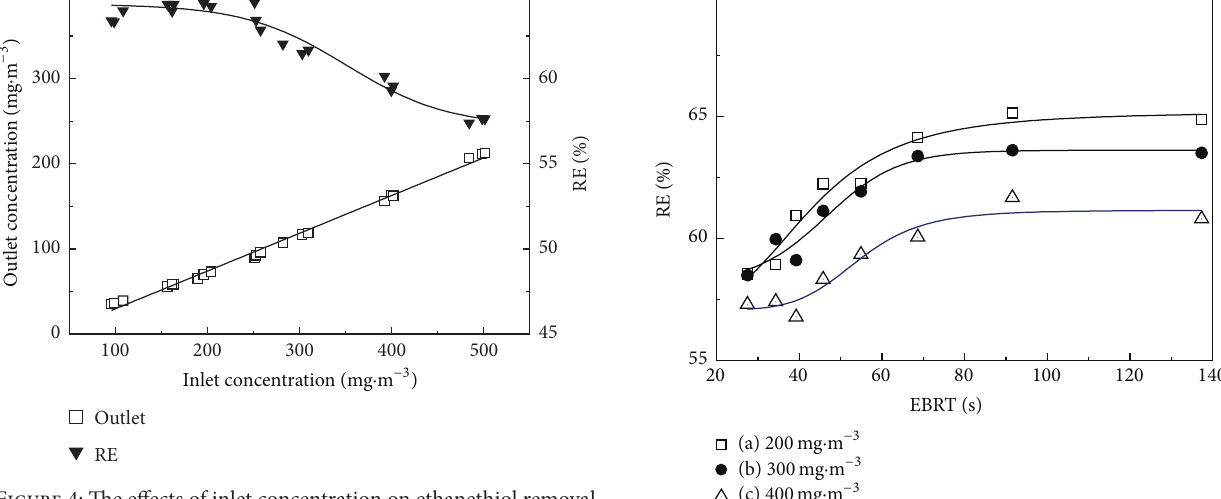
Figure 4: The effects of inlet concentration on ethanethiol removal efficiency.